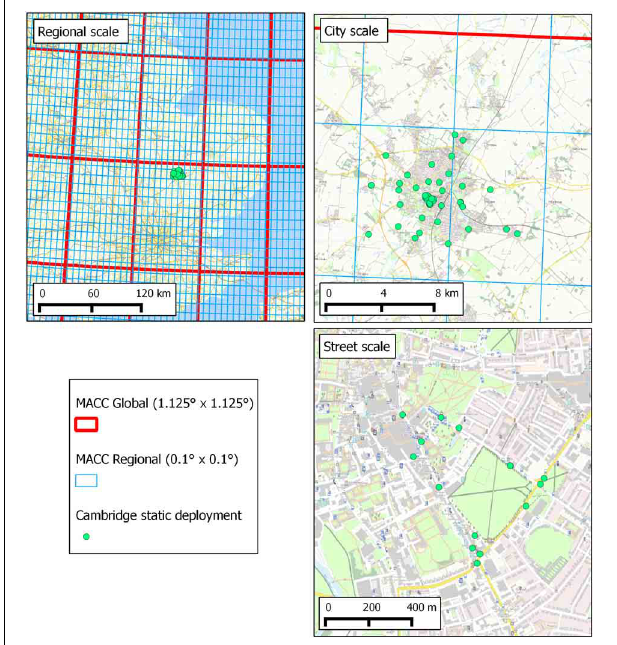
FIGURE 9 | Illustration of significant differences in spatial scale between operational atmospheric modeling and typical data assimilation applications (case 1); and urban air quality applications (case 2). Spatial scales associated with case 1 are exemplified by the global and regional grids used by the MACC-II project as a precursor of the Copernicus Atmospheric Monitoring Service—top left-hand panel (labeled regional scale). Spatial scales associated with case 2 are exemplified by the observations of gases relevant for urban air quality (CO, NO, and NO 2 ) collected by low-cost, high-density monitoring networks by the University of Cambridge—top right-hand panel (labeled city scale), and bottom right-hand panel (labeled street scale). Spatial resolutions of the global and regional scale MACC models identified in the top two panels are, respectively, 1.125 ◦ × 1.125 ◦ and 0.1 ◦ × 0.1 ◦ . The University of Cambridge data are described in Mead et al.